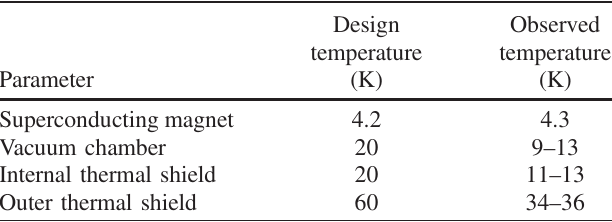
TABLE IX. SCU0 design and observed temperatures.